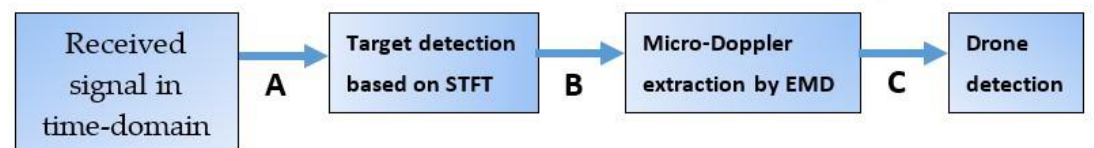
Figure 8. Signal processing for drone detection in passive FSR.